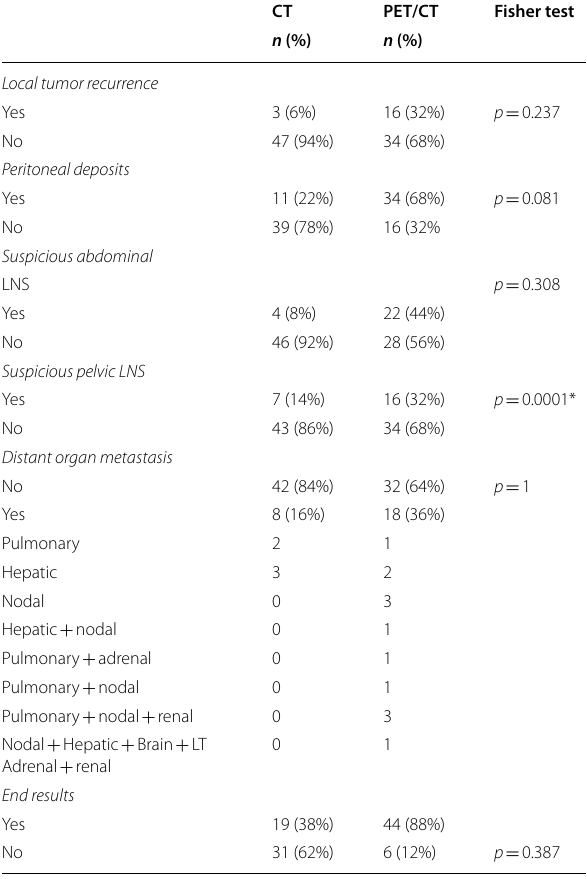
Table 5 Diagnostic performance of combined PET/CT in ovarian cancer recurrence